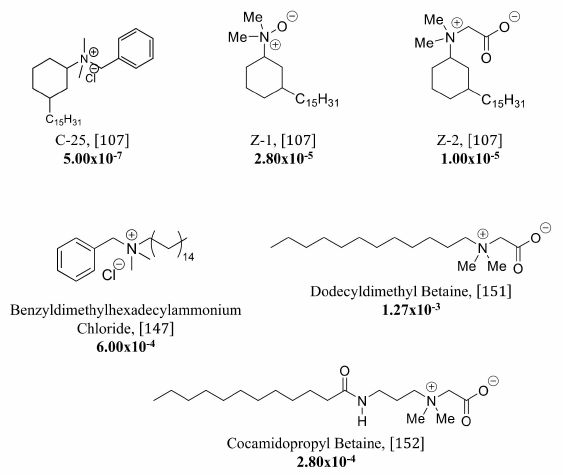
Figure 15. CMC (mol/L) of ionic CNS-based surfactants with 5-pentadecylcyclohexane as hy- drophobic